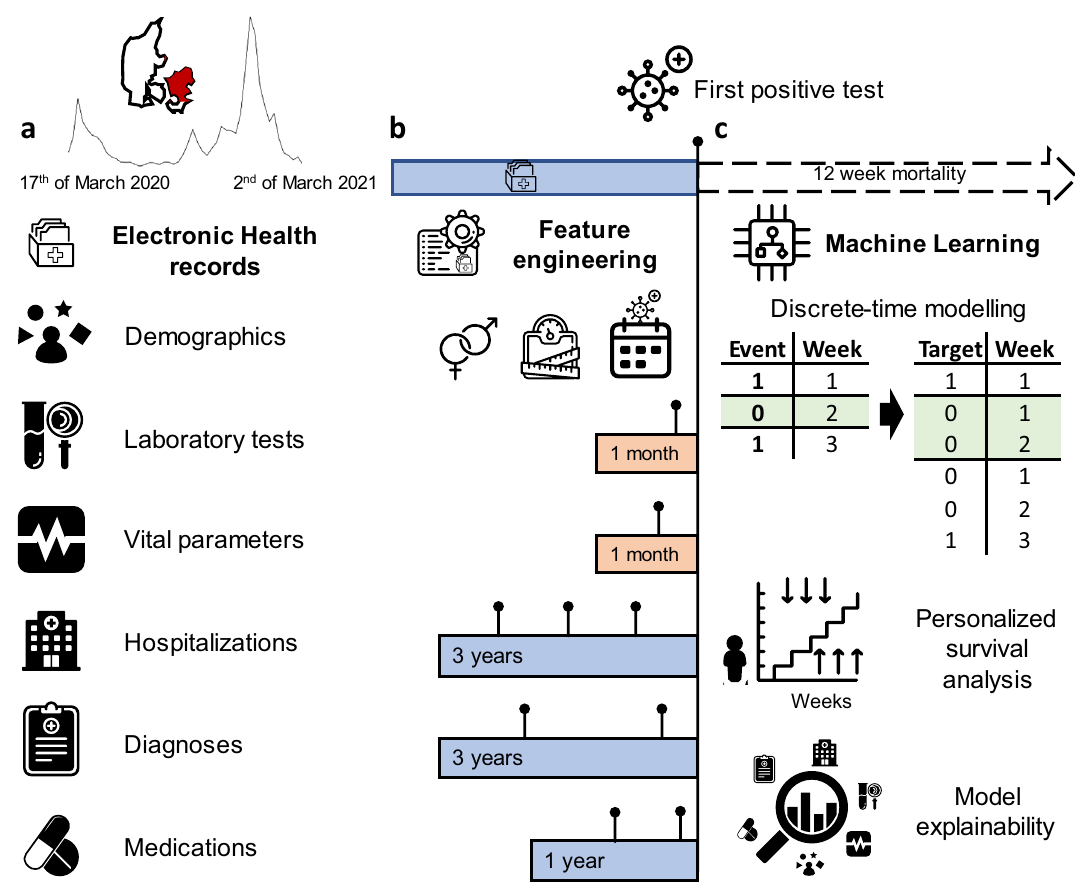
Figure 1. Overview of the data sources, feature engineering and modelling approach for predicting 12-week mortality in SARS-CoV-2 positive patients. ( a ) Electronic Health Records (EHR) of 33,938 patients from 17th of March 2020 to 2nd of March 2021 (incidence curve) in eastern Denmark (geographical region visualized in red) were used to predict 12-week mortality from the first positive SARS-CoV-2 test (FPT). ( b ) Features were engineered as the last value observed prior to FPT within the last month for vitals and laboratory values. To encode hospital admissions, medications and diagnoses, the count of occurrences within three or one year(s) prior to FPT was used. ( c ) Machine learning algorithms were trained for survival modelling using a discrete- time approach. Time-to-event data were transformed longitudinally into patient-weeks up to the loss of follow-up (0) or death (1). With the augmented data, binary classification was performed by gradient boosting decision trees to predict personalized survival distributions for each patient and provide explanations of individual risk factors using SHAP